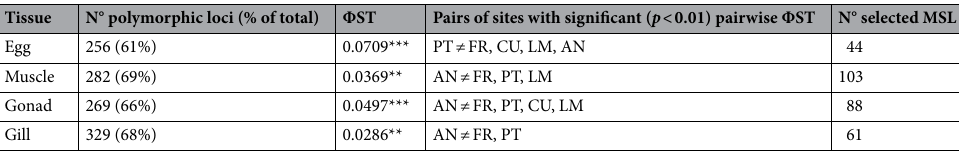
Table 4. Number of Polymorphic loci, ΦST, pairwise ΦST comparisons among sites for the Methylation Sensitive Loci (MSL) and number of selected MSL after locus-per-locus Chi-squared test (see “Material and methods”) for female tissues and eggs. Asterisks indicate the significance of the ΦST: *** p < 0.0001; ** p < 0.01. FR, El Frances; PT, Punta Tralca; CU, Los Cuervos; LM, Los Molinos; AN,